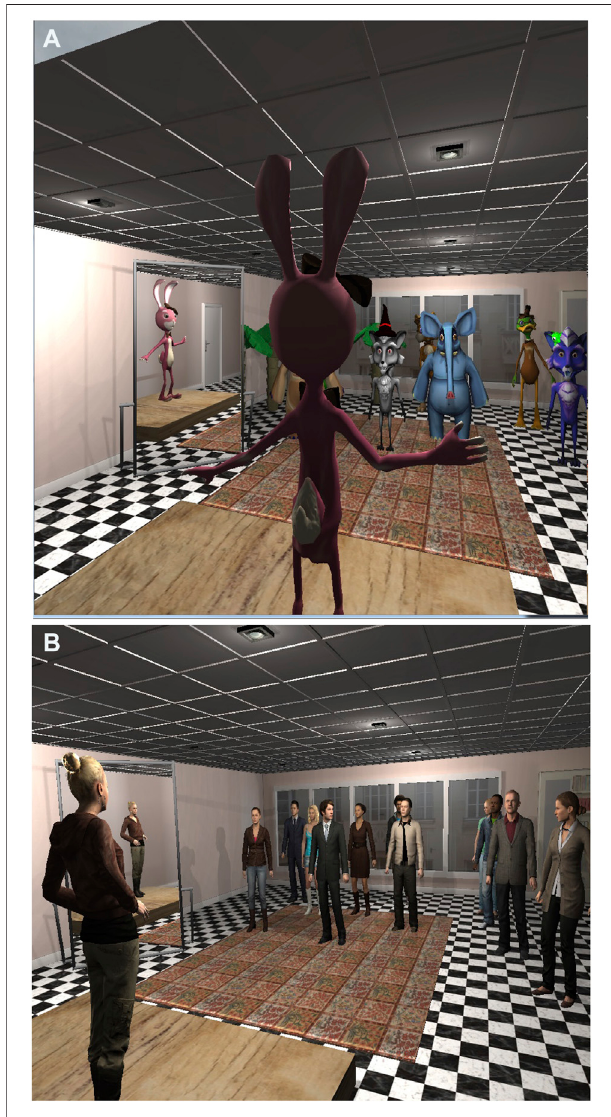
FIGURE 1 | The scenario (A) The Cartoon condition. (B) The Human condition. The 3PP condition looked the same as the Cartoon except that the participant was not embodied in the bunny